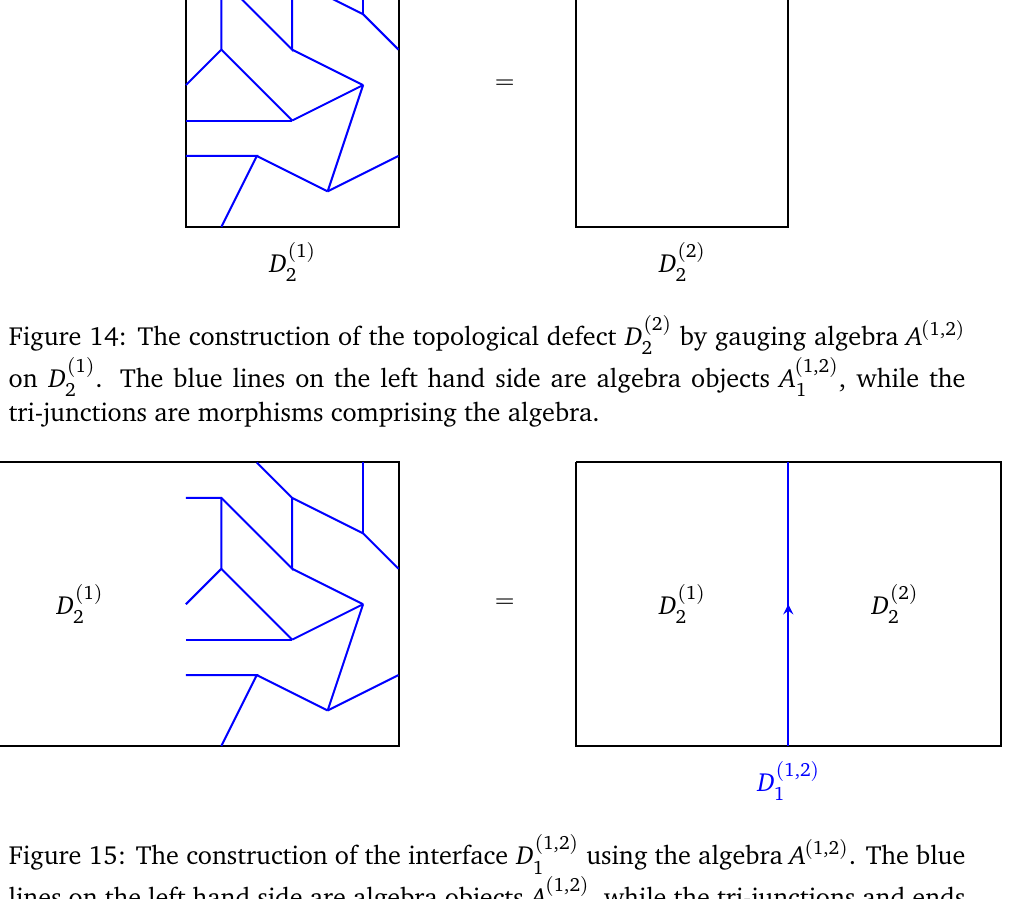
using the algebra A p 1,2 q . The blue 1 , while the tri-junctions and ends 1